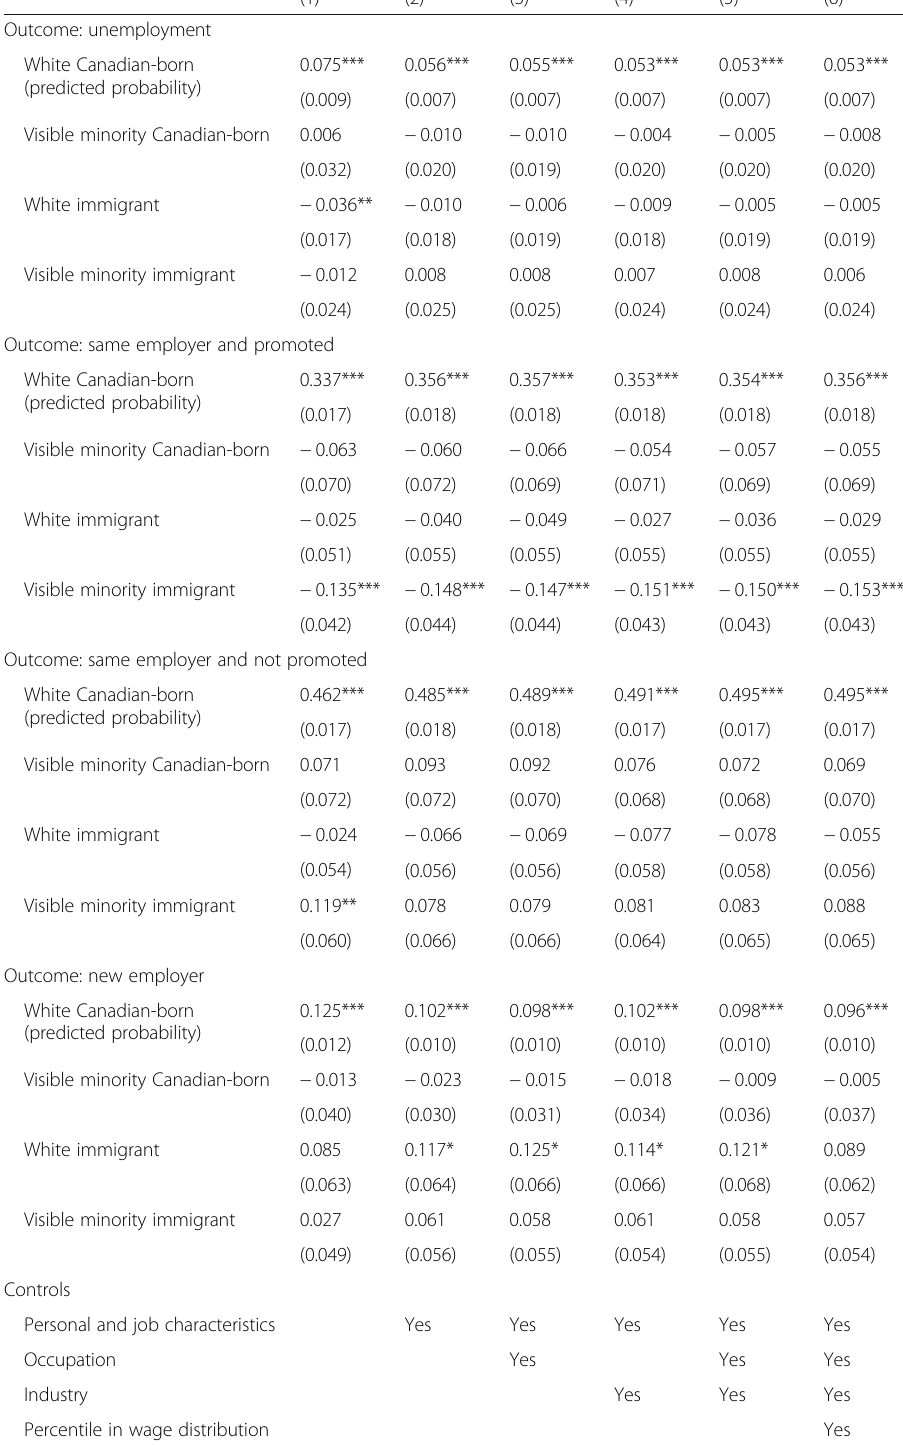
Table 2 Multinomial logit estimates of transition